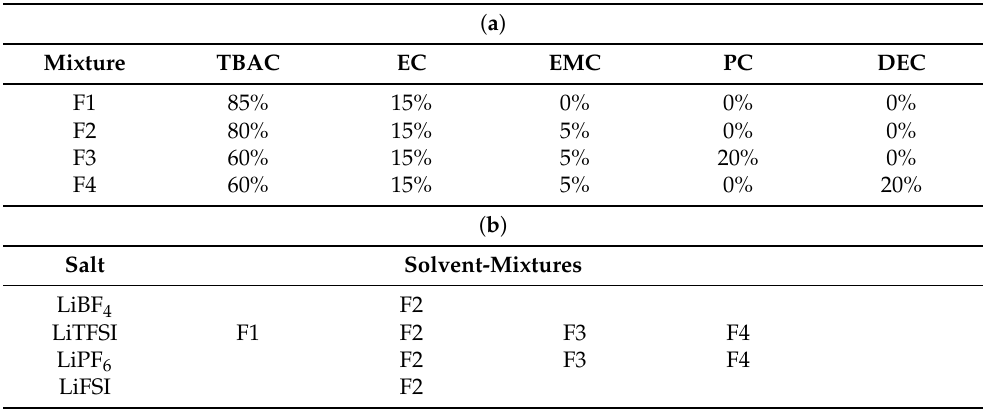
Table 1. ( a ) Formulated solvent-mixtures wt. ( b ) Investigated combinations of lithium salts and solvent-mixtures (concentration of 1 M).